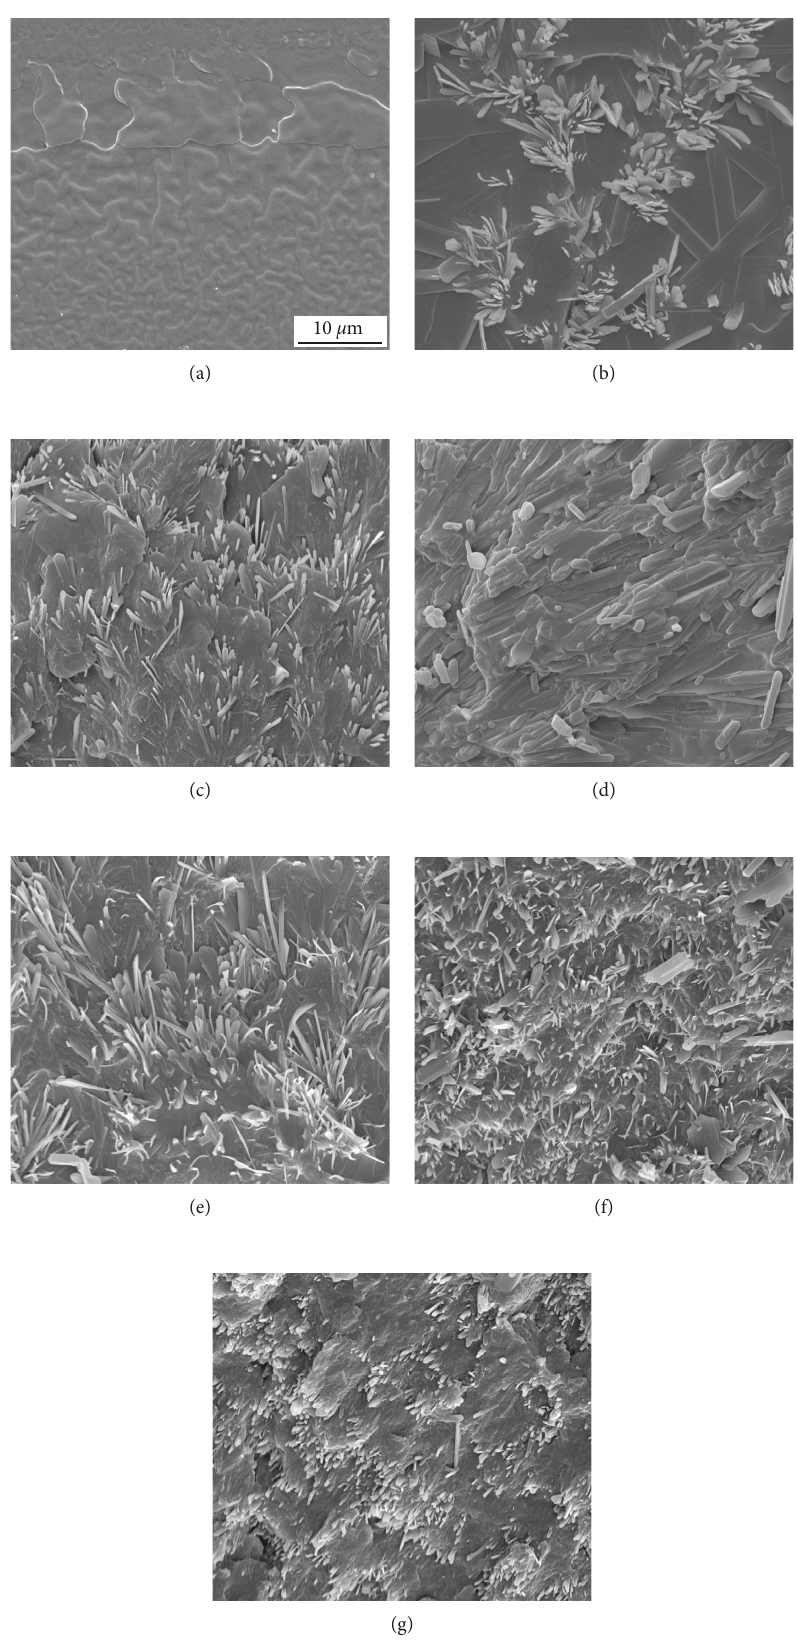
Figure 2: SEM images of fracture surfaces of 329-composites with different mass ratios of 329: (a) 10%, (b) 20%, (c) 25%, (d) 30%, (e) 40%, (f) 50%, and (g)